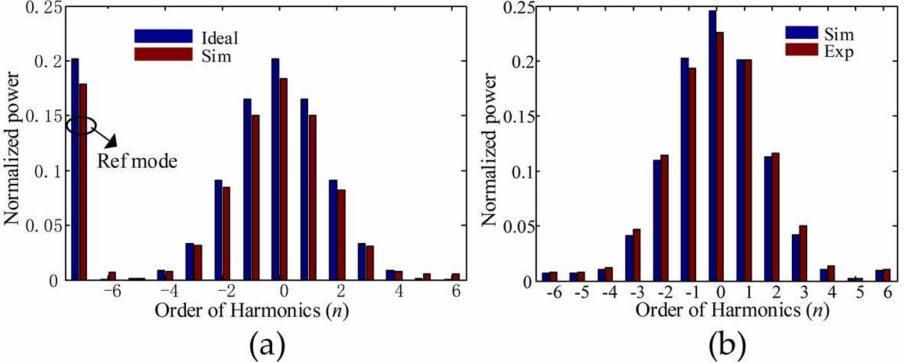
Figure 10. ( a ) Normal harmonic distributions of the spinning object. ( b ) Comparison between measured and theoretical results of harmonic distribution. Adapted with permission from ref.